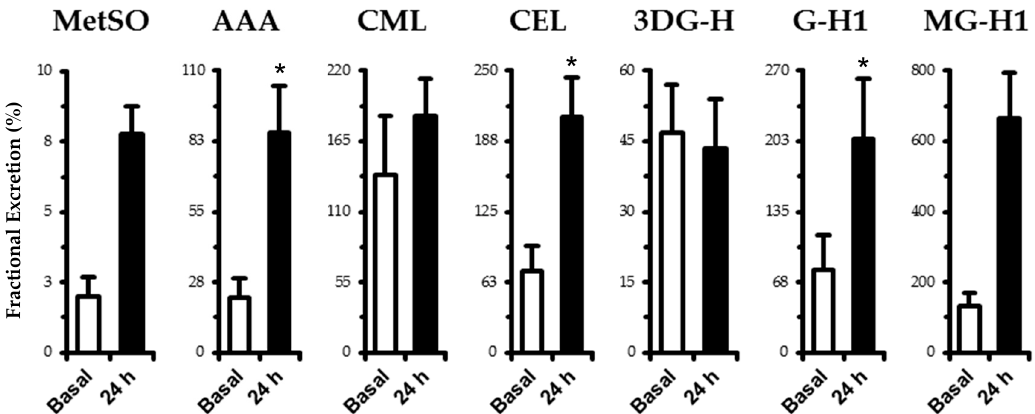
Figure 1. Fractional excretion of oxidation (MetSO and AAA) and AGE-free adducts (CML, CEL, 3DG-H, GH-1, and MG-H1) in human plasma. Samples were taken in the basal state following an overnight fast and after 24 h of experimental hyperglycemia (+5.4 mM above basal plasma glucose levels). See fractional excretion in Materials and Methods for computational details. Data are mean ± SE. * p < 0.05 vs. basal.